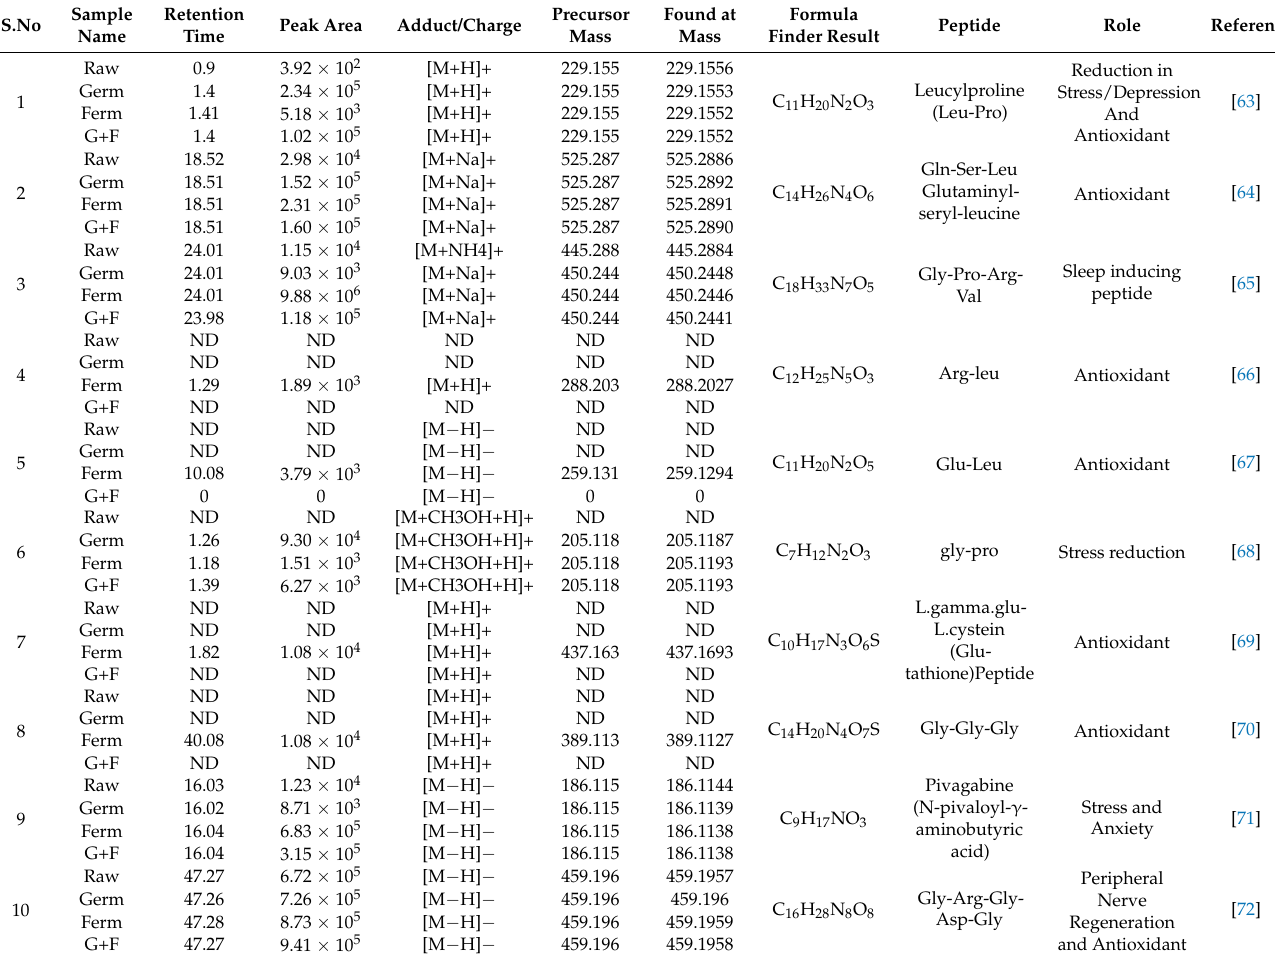
Table 2. Identification of peptides in different processed brown rice